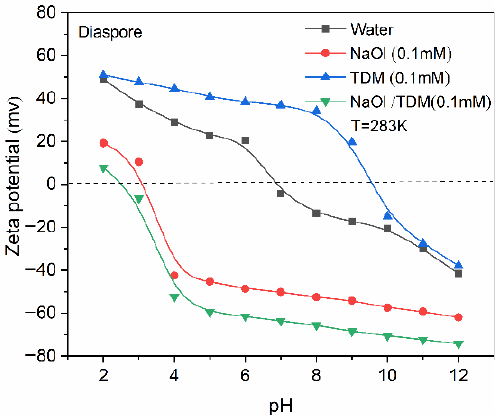
Figure 7. Zeta potentials of diaspore in the presence of various flotation reagents at 283 K.